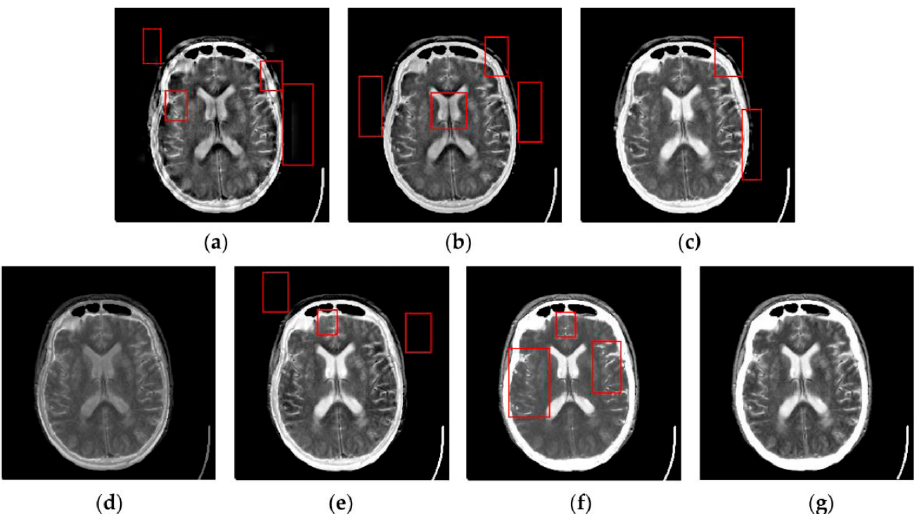
Figure 7. Fused results of the evaluated methods for the first group of source images shown in Figure 6a,b: ( a ) the discrete wavelet transform (DWT) method; ( b ) the non-subsampled contourlet transform (NSCT) method; ( c ) the NSCT-SR method; ( d ) the multi-channel pulse coupled neural network (m-PCNN) method; ( e ) the PCNN-NSCT method; ( f ) the SCM-F method; and ( g ) the SCM-M method.